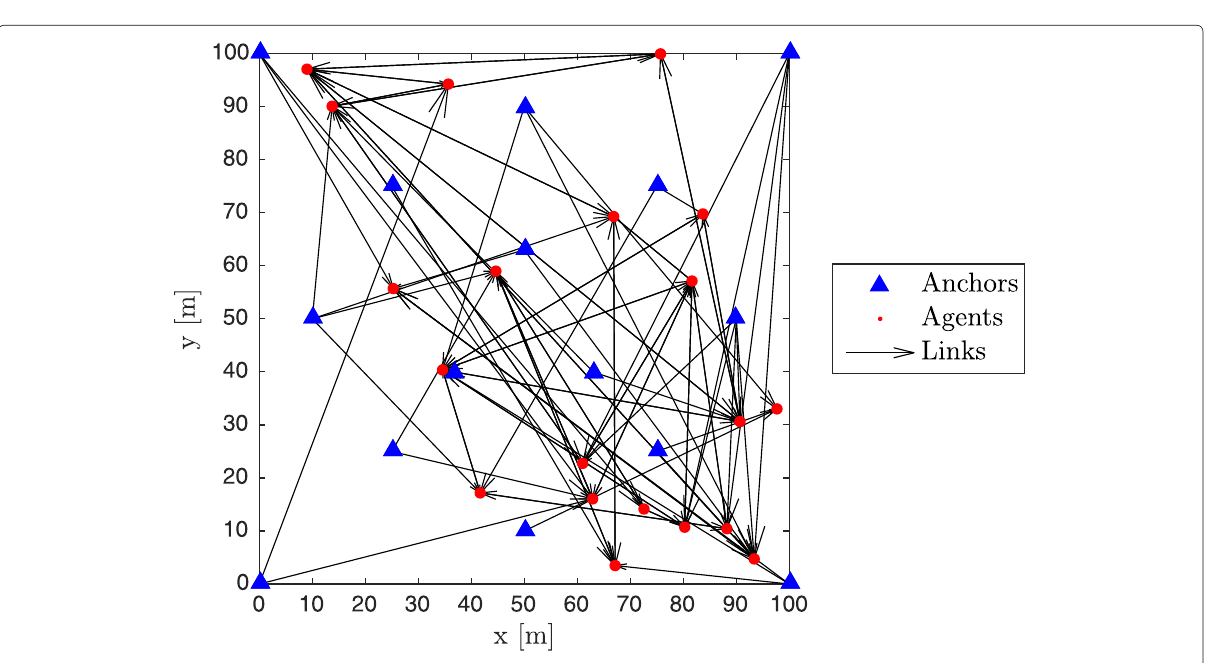
Fig. 2 Example of a compatible graph with N a = 15, N u =